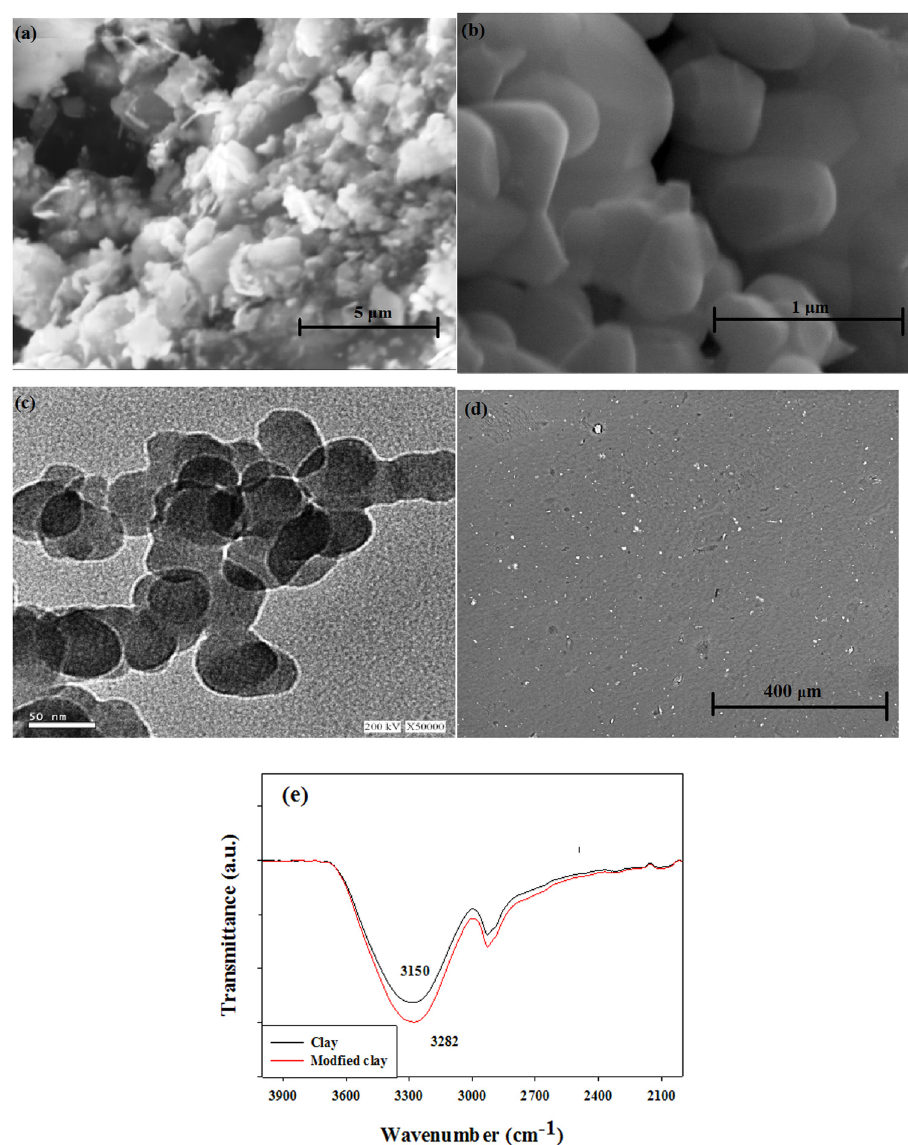
Figure 1: ( a ) SEM photomicrograph of clay and ( b ) CB. ( c ) TEM photomicrograph of CB, ( d ) SEM photomicrograph of the CB/clay/blend rubber surface, and ( e ) FTIR of clay and modi fi ed